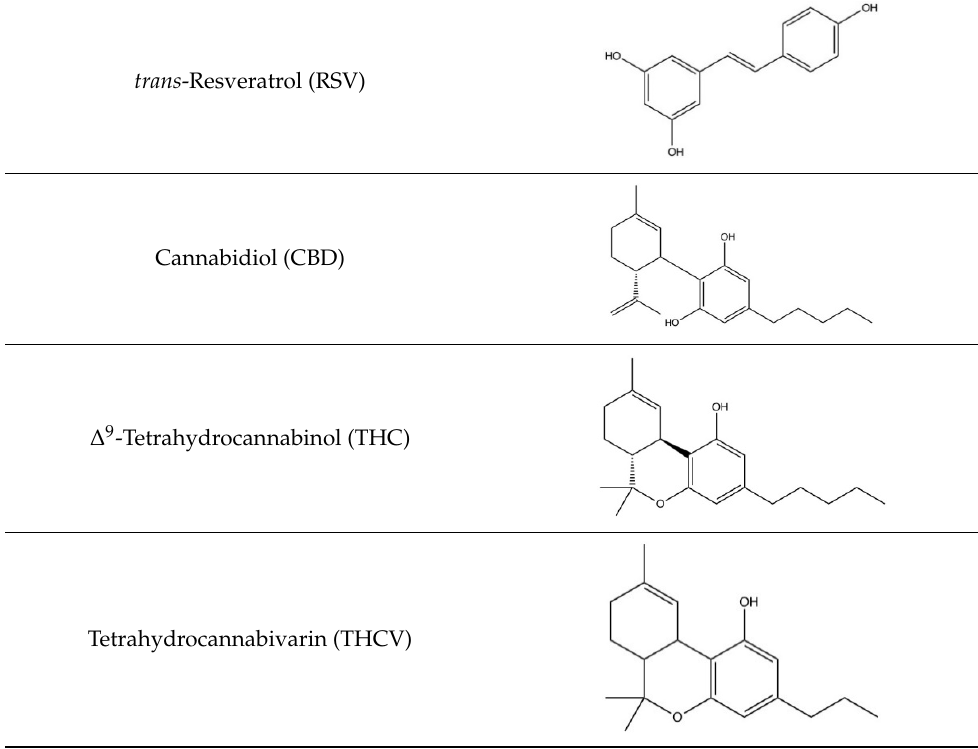
Table 1. Skeletal structures of the neuroprotective agents assessed in this